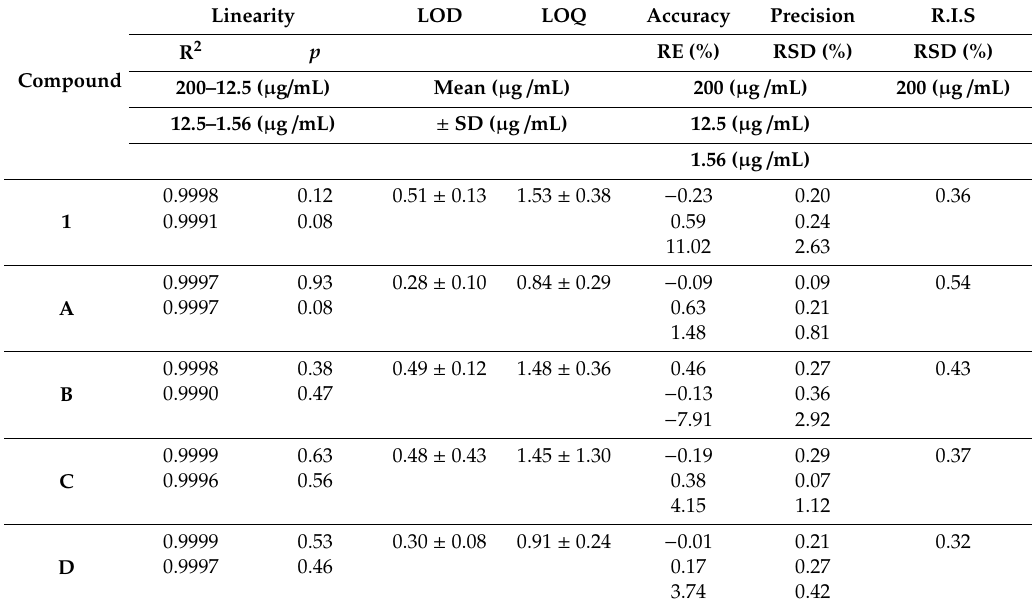
Table 1. Linearity (expressed in R 2 and p with two ranges, one by row), Precision, Accuracy (calculated at maximum, medium, and minimum concentration values), and Repeatability of the HPLC Method for the determination of